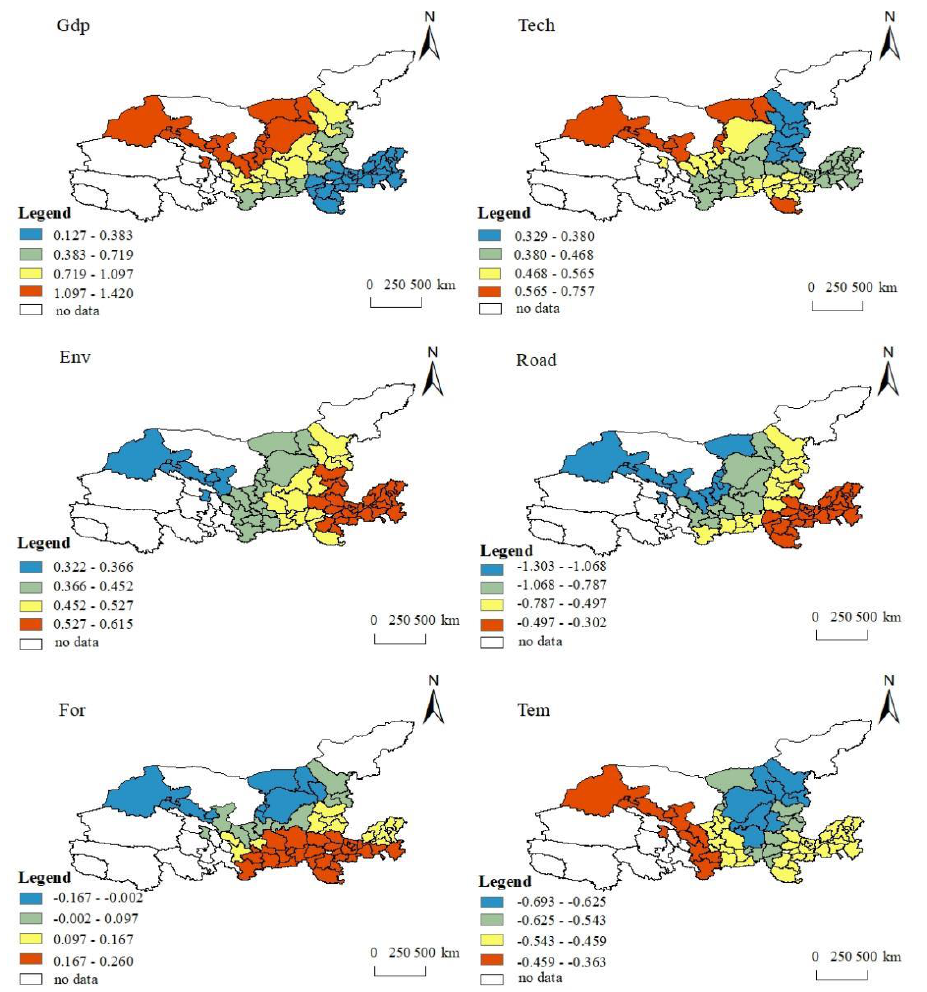
Figure 7. Spatial heterogeneity of the influencing factors of the coupling and coordination degree of urban ESV and urbanization in the Yellow River Basin, China.